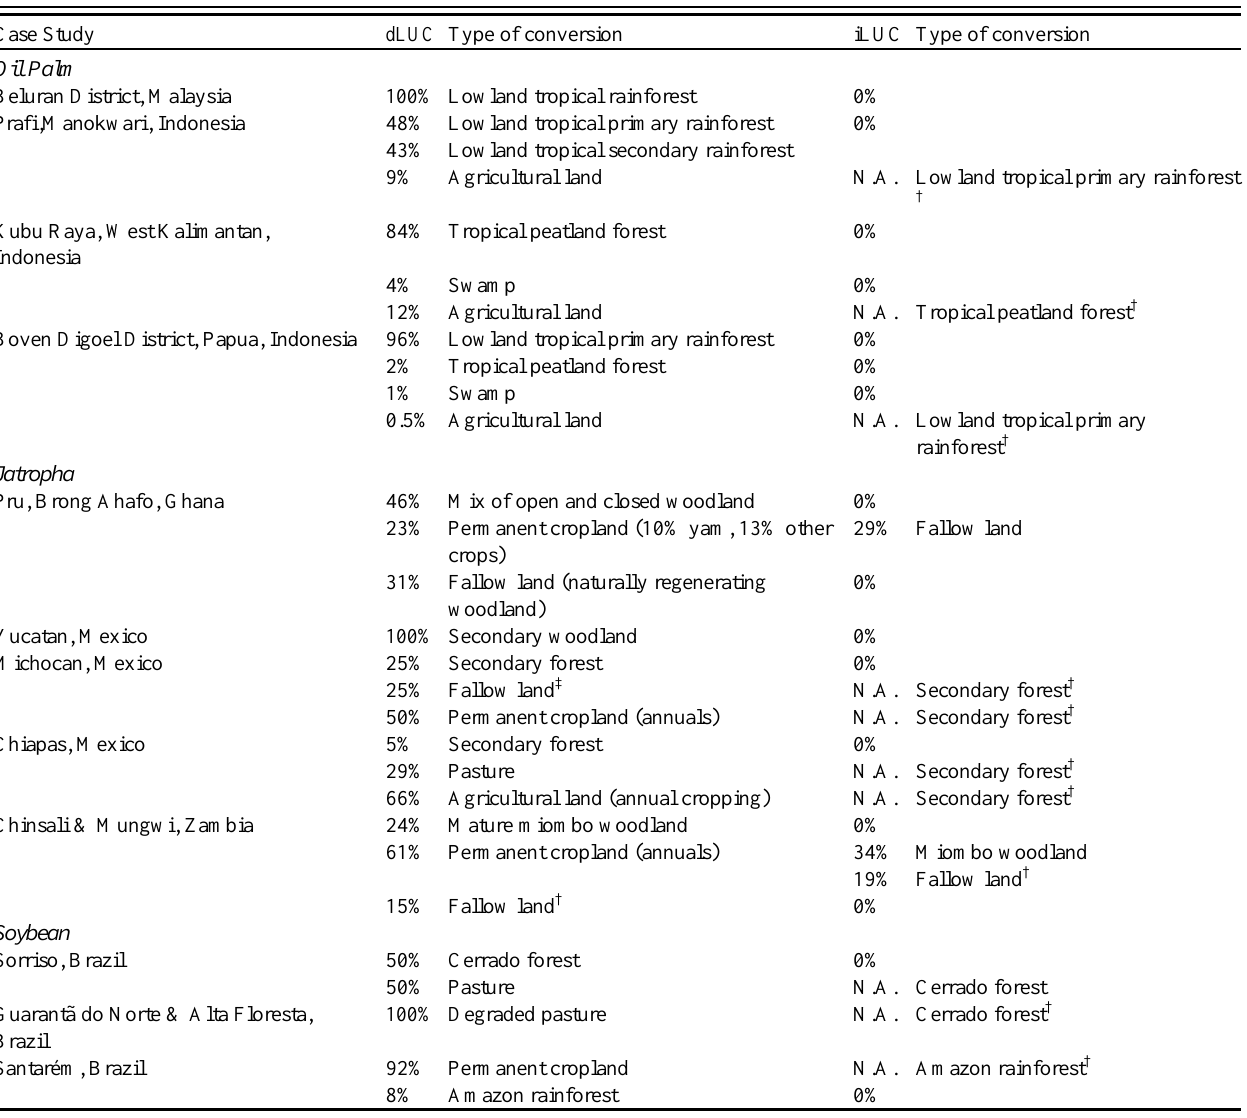
Table 1. Area converted to biofuel and the direct (dLUC) and indirect land-use change (iLUC) thus triggered Case